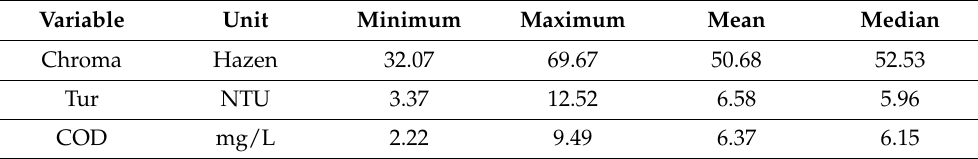
Table 1. Detailed statistics of the